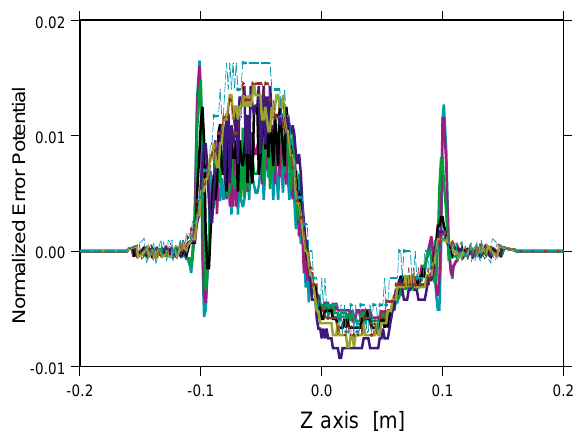
FIG. 4. (Color) Relative error (cid:1)(cid:1)(cid:1) u slice (cid:1) r , z (cid:2) 2 u SOR (cid:1) r , z (cid:2)(cid:2)(cid:2)(cid:2)(cid:3) u max (cid:1) r , z (cid:2) between the slice algorithm and SOR-3D results of Fig. 3. The maximal error is within 1.6%. representation of the longitudinal fields while being com- putationally very fast. For the configuration of Fig. 1, but using the slice tech- nique with the beam bunch represented as a sequence of 100 thin disks, the longitudinal space charge poten- tial was also calculated. Shown in the left-hand side of Fig. 3 is u (cid:1) r , z (cid:2) found by the SOR-3D algorithm and on the right-hand side found by the slice algorithm for radial coordinate (cid:1) r (cid:2) values varying from 0 to 2 cm. The poten- tials within the beam of Fig. 1 are shown as solid lines and those outside with dashed lines.